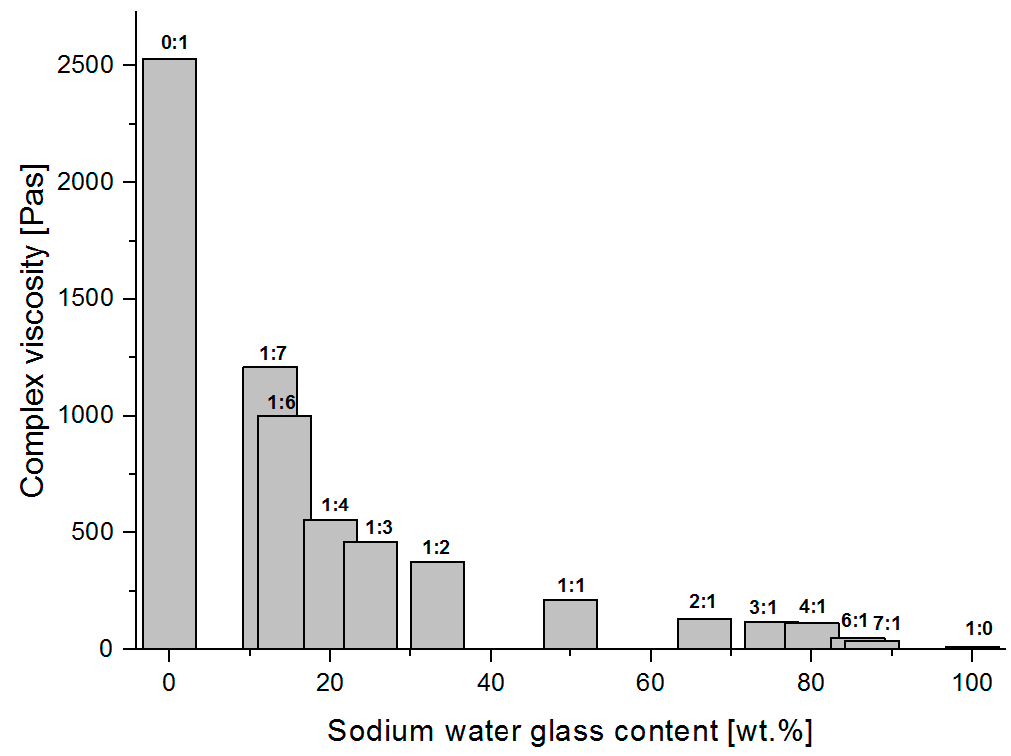
Figure 13. The dependence of the complex viscosity versus sodium water glass content of the tested polymer-silicate hydrogel samples.